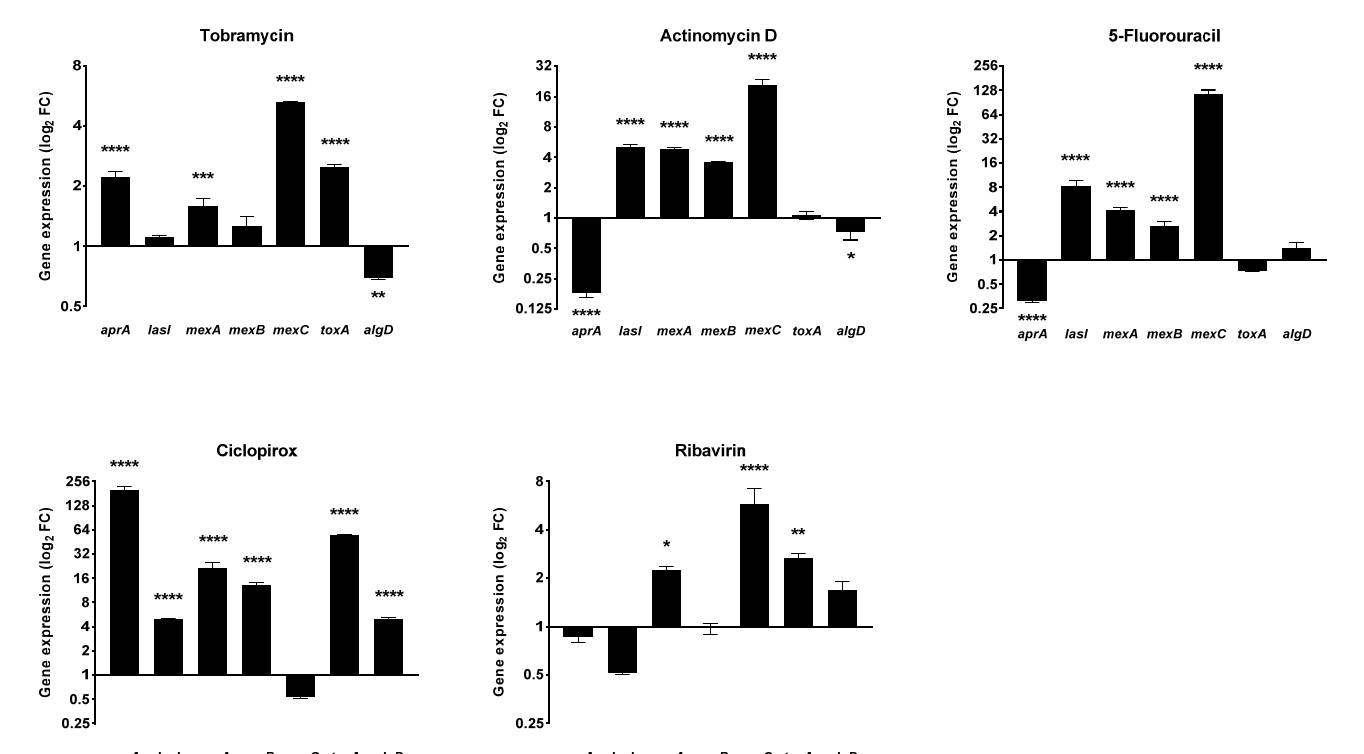
Figure 9. Effect of drugs exposure on the expression of selected P. aeruginosa virulence genes. The effects of exposure to actinomycin D, 5-fluorouracil, ciclopirox, and ribavirin on the expression levels of P. aeruginosa PaPh32 virulence genes aprA (alkaline protease), lasI (quorum sensing), mexA , mexB, and mexC (efflux pumps), toxA (exotoxin A), and algD (alginate) were assessed, comparatively to tobramycin, by real-time RT-qPCR assay. Each drug was tested at 1/4xMIC for 20 h, while controls (CTRL) were not exposed to the drug. The relative expression of each gene was normalized on the housekeeping proC gene. Results are shown as means + SDs ( n = 6) of fold change (FC: 2 −ΔΔ ct ) on a log 2 scale. Statistical significance at ANOVA followed by Tukey’s multiple comparisons post-test: * p < 0.05, ** p < 0.01, *** p < 0.001, and **** p < 0.0001 vs. CTRL.